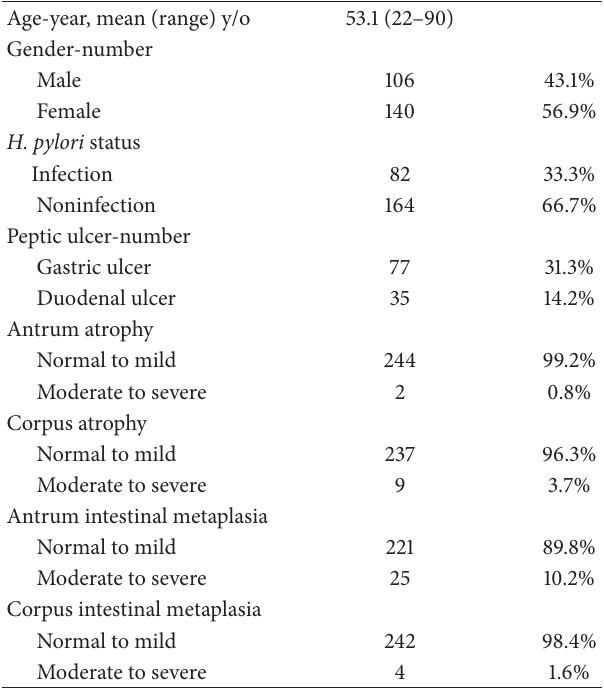
Table 1: Demographic characteristics of patients.